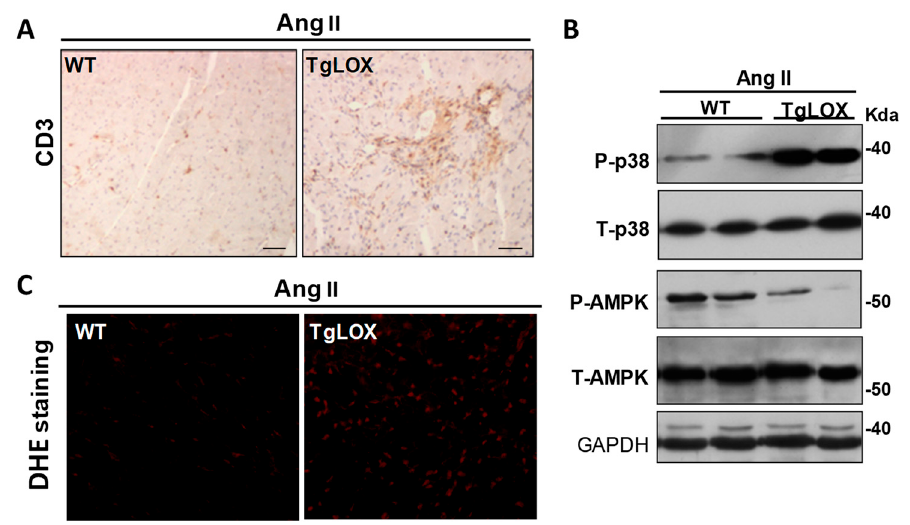
Figure 6. LOX transgenesis aggravates Ang II-induced cardiac inflammation and oxidative stress and disturbs Ang II-dependent signaling pathways. ( A ) WT and TgLOX mice were infused with AngII (1000 ng/kg/min) or saline solution for 14 days. Inmunohistochemistry revealed that Ang II- challenged TgLOX mice exhibited higher myocardial lymphocyte infiltration (CD3+) than WT animals. ( B ) Representative Western blot assays performed in heart lysates from these animals showing that LOX transgenesis alters the activation by phosphorylation of both p38 MAPK (p38) and AMPK (p-p38 and p-AMPK, respectively). Total p38 and AMPK levels are also shown. Glyceraldehyde 3-phosphate dehydrogenase (GAPDH) protein levels were analyzed as loading control. The position of the molecular weight standards (HyperPAGE prestained protein markers, BIOLINE; Ref: BIO-33065) is indicated. ( C ) Dihydroethidium (DHE) staining revealed that LOX overexpression exacerbates the Ang II-mediated increase in cardiac superoxide anion production.